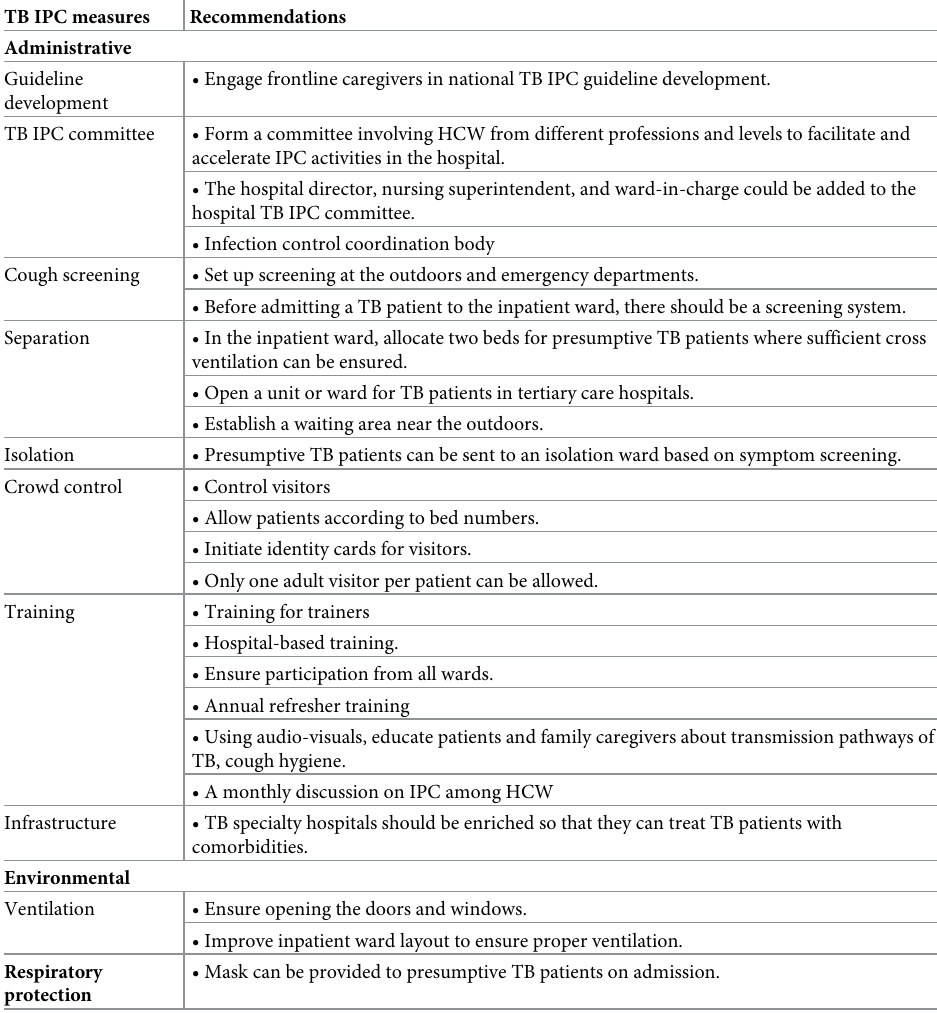
Table 2. Participants’ recommendations for TB IPC implementation in health